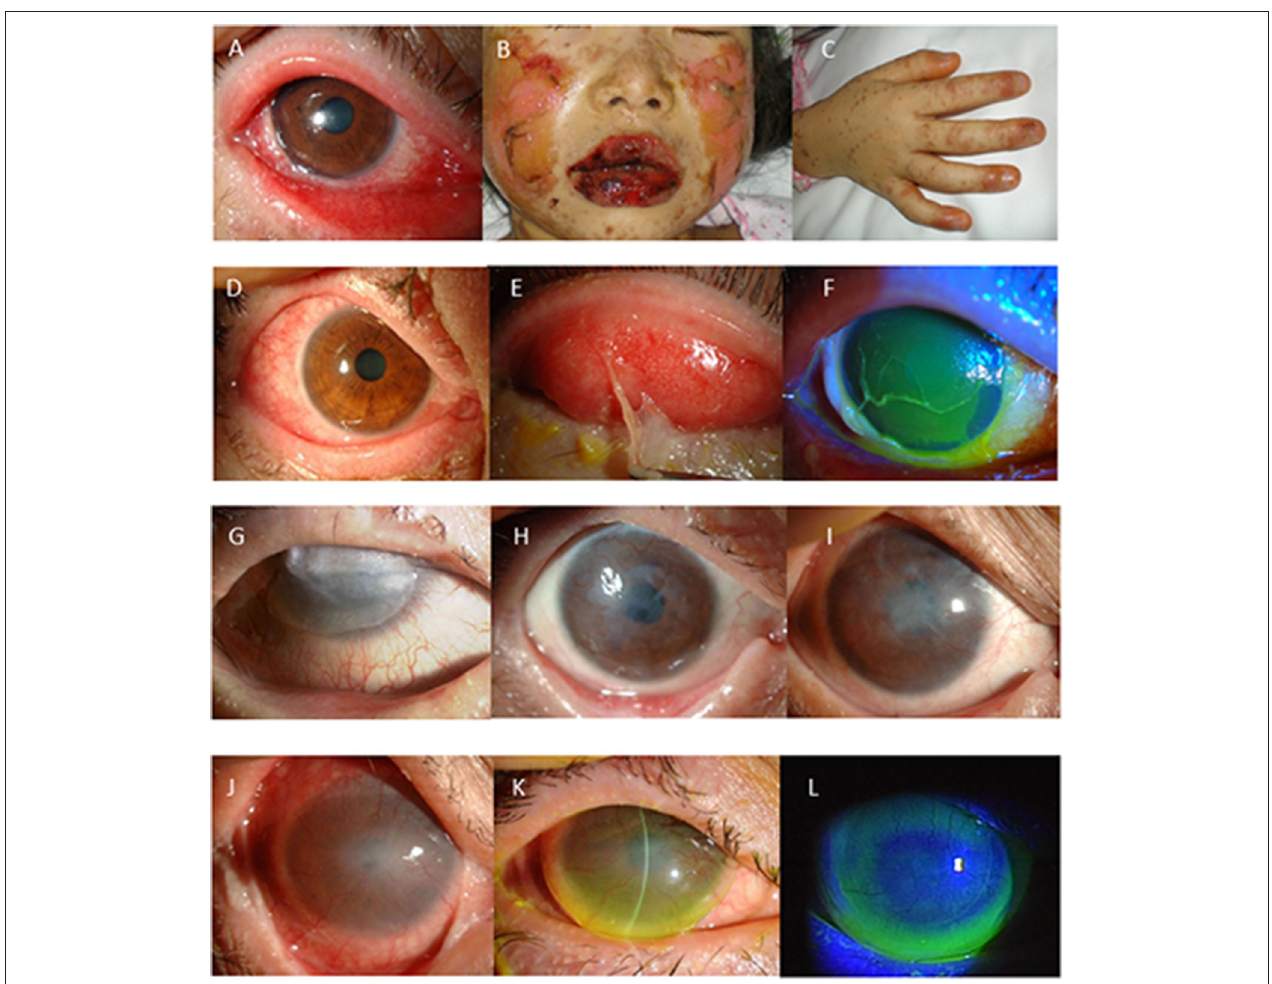
FIGURE 1 | (A–F) Representative photographs showing Stevens-Johnson syndrome/toxic epidermal necrolysis (SJS/TEN) at disease onset with severe ocular complications (SOC). (A) Conjunctivitis, which was accompanied by extensive loss of corneal and conjunctival epithelium. (B) Swollen and crusted lips. (C) Paronychia. In 66% of the patients, conjunctival hyperemia (D) preceded skin eruption. Pseudomembrane formation (E) and corneal or conjunctival epithelial defect (F) develop at the acute stage. (G–I) Long-term effect of cultivated oral mucosal epithelial transplantation (COMET). Images of SJS/TEN cases obtained at before (G) and at 2-years (H) and 5-years postoperative (I) . (J–L) Use of a limbal-supported rigid-type contact lens (Limbal-Rigid CL; Sun Contact Lens) for the treatment of SJS/TEN with ocular disorders. Representative appearances of the eyes with SJS/TEN at before (J) and after 3-months use of the Limbal-Rigid CL (K,L)